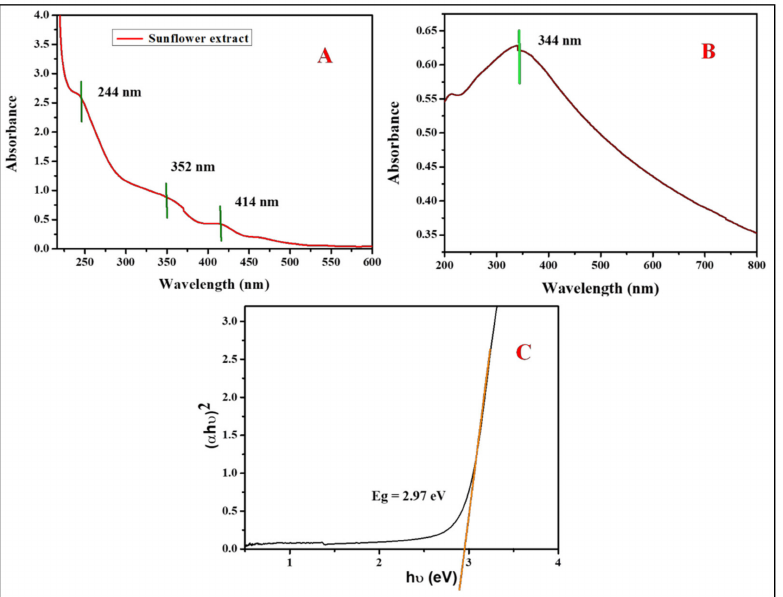
Figure 3. UV-Visible analysis of sunflower-leaf aqueous extract mediated by synthesized ZnO nanoparticles: ( A ) UV-Visible spectrum of sunflower-leaf aqueous extract; ( B ) UV-Visible absorbance spectrum of ZnO nanoparticles; ( C ) UV-DRS spectrum of ZnO